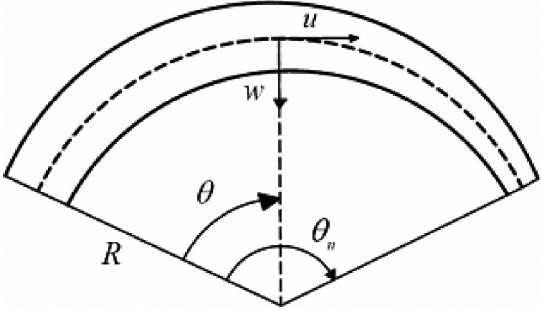
Fig. 1. General curved beam con fi